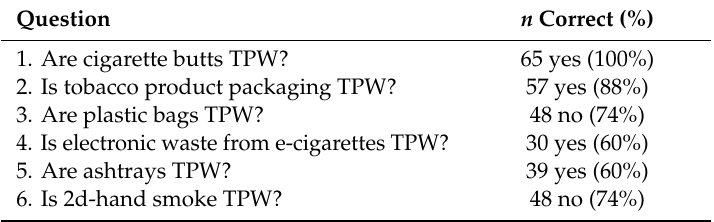
Table 1. Knowledge about Tobacco Product Waste, Members of Framework Convention Alliance, 2019 ( N = 65).